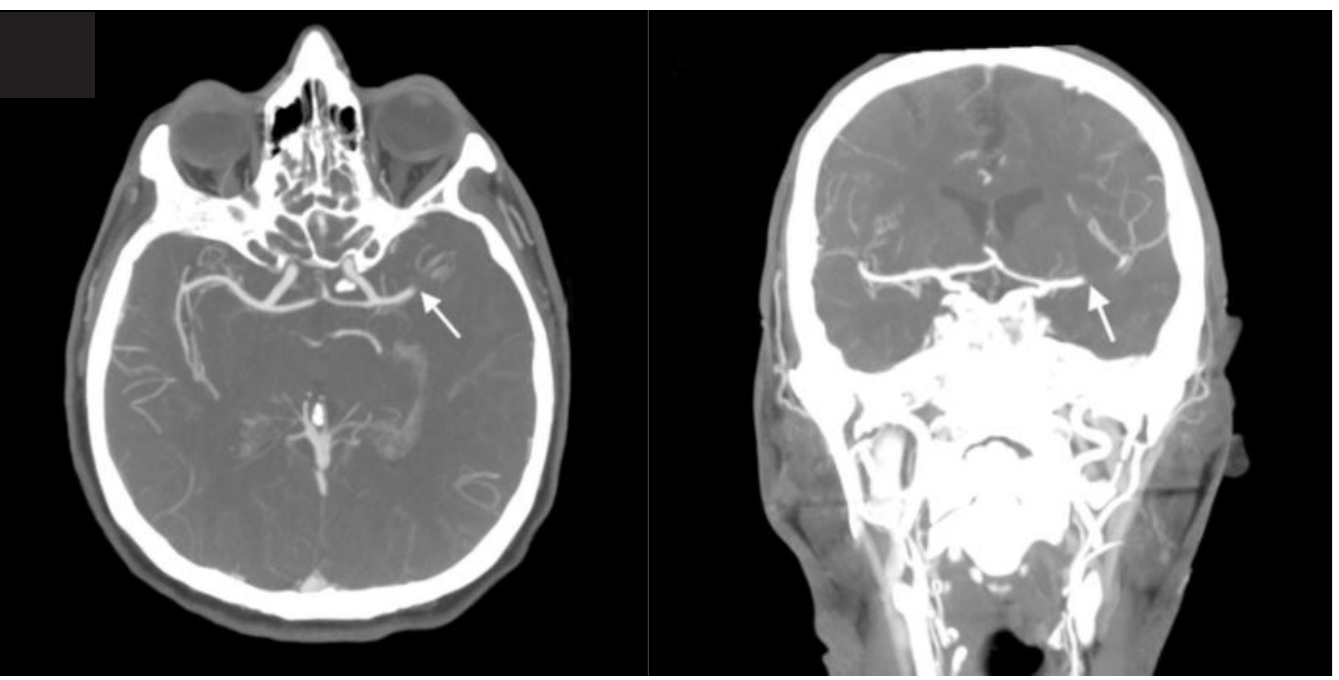
Figure 1. Transverse (left) and coronal (right) computed tomography angiogram demonstrating abrupt cutoff of the left middle cerebral artery at the site of the thrombus (marked by